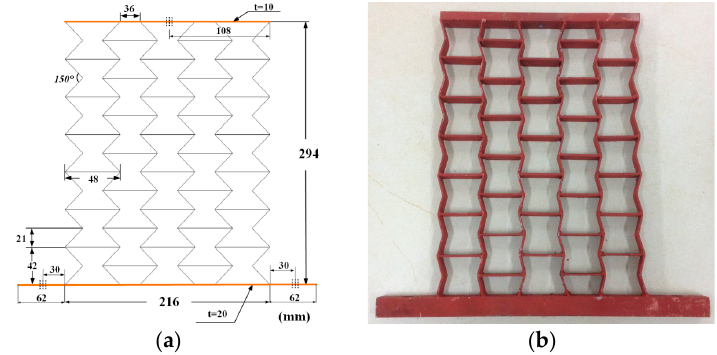
Figure 10. Testing samples with the cell angle θ = − 15 ◦ : ( a ) geometric dimensions; ( b ) photo.